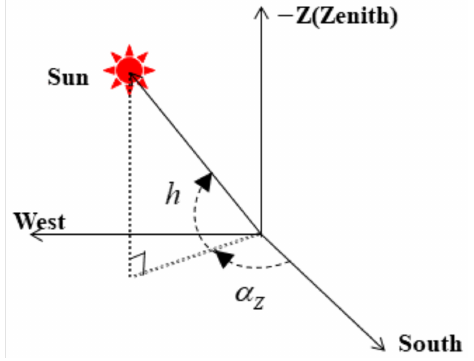
Figure 3. Sketch of the position of the